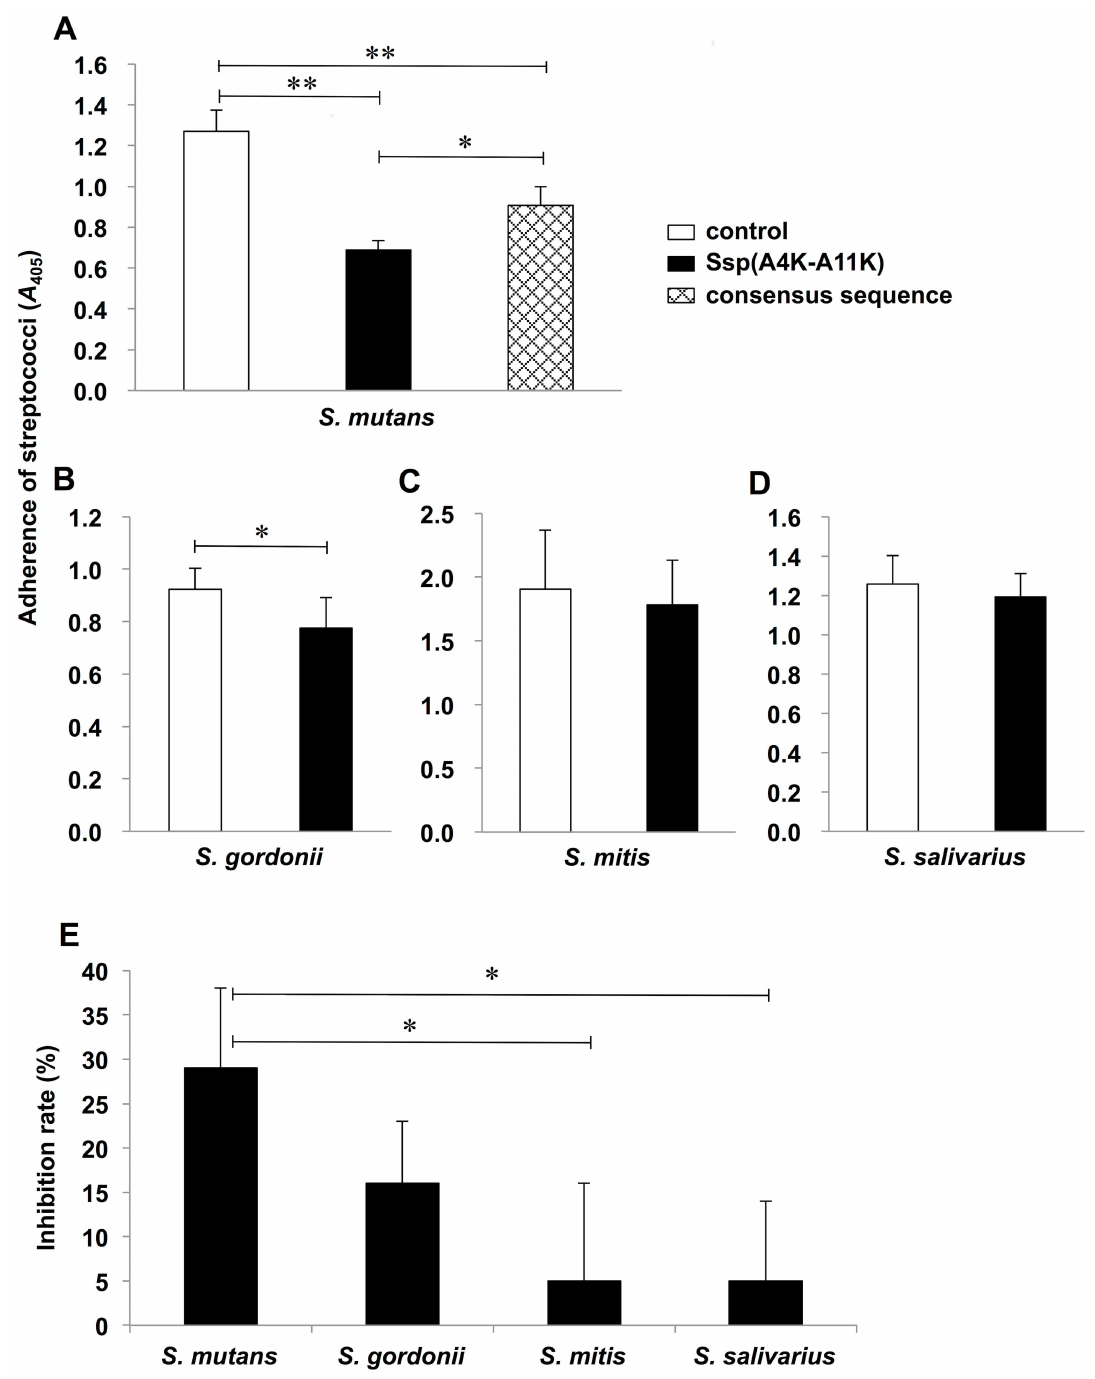
Fig 1. Effect of Ssp(A4K-A11K) on streptococcal adherence to saliva-coated surfaces. (A) S . mutans . (B) S . gordonii . (C) S . mitis . (D) S . salivarius . (E) Inhibitionrate of streptococcal adherence to saliva-coated surfaces. Data are expressedas mean absorbanceat 405 nm ± standard deviations (SDs) of three independentexperiments with technicalreplicates. Asterisks denotesignificantdifferences(control: DW; * P < 0.05, ** P < 0.01).